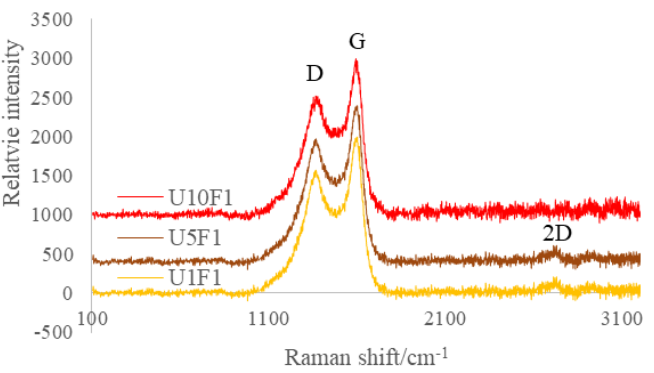
Figure 5. Surface chemistry analyses by Raman on CFs sized with different amount of CNFs.